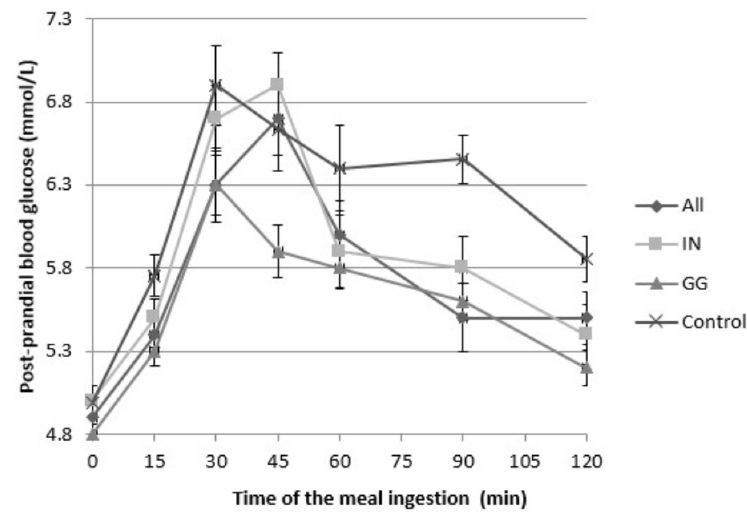
Figure 1. The glycaemic response for Pita breads.